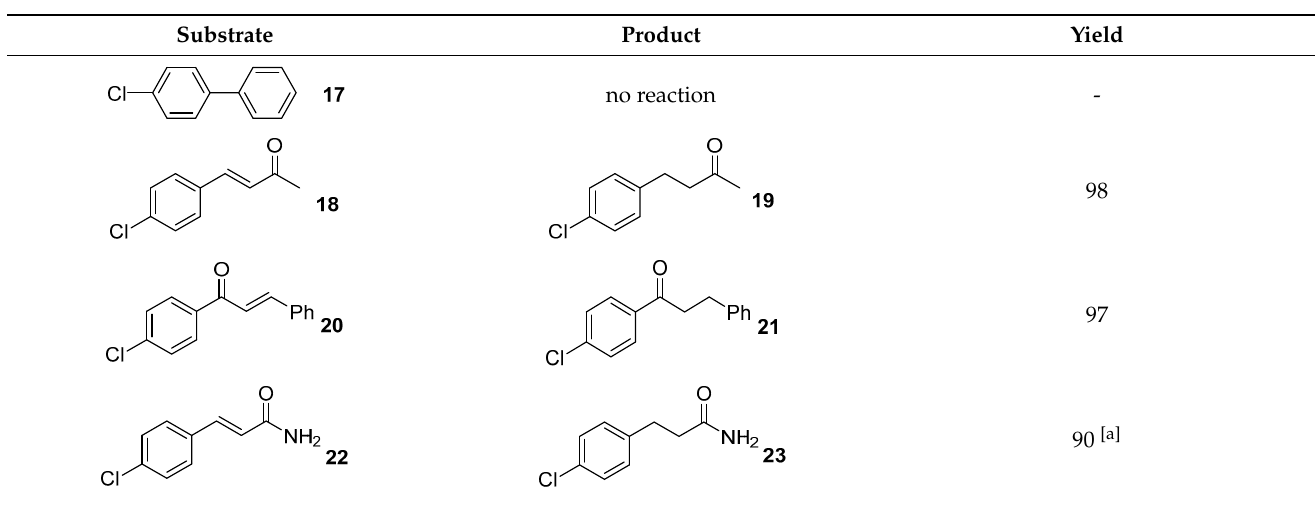
Sajiki and co-workers discovered chemoselective hydrogenation of olefins in the Table 1. Application to Aromatic Halogen. presence of diphenyl sulphide (Ph 2 S) [32–34]. The high catalytic activity of Pd/C resulted in poor selectivity of hydrogenation. Moreover, catalyst poison was introduced into the reaction. Diphenyl sulphide (Ph 2 S) was selected as a new type of catalyst poison to sup- port Pd/C. Olefins were treated with hydrogen in MeOH at room temperature and gave Substrate chemoselective products in good to excellent yields (up to 100%) (Tables 1 and 2).